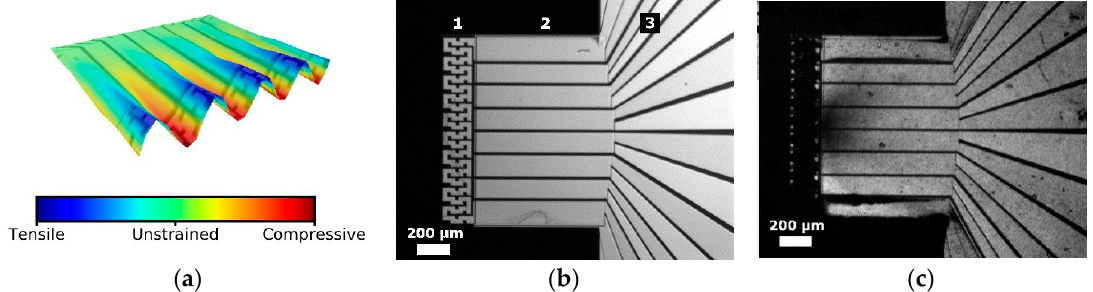
Figure 1. ( a ) Laser Doppler Vibrometer measurement showing the mode shape of the 8th order roof- tile mode. The red and blue colored areas represent the strain distribution (tensile, compressive) on the surface. ( b ) Optical micrograph of the sensor element. The planar coil (1) accumulates the magnetic particles on the cantilever (2) which is fixed to a substrate (3). The patterned electrode design is optimized to excite the 8th order roof tile mode. ( c ) Optical micrograph of the sensor element during the experiment. The accumulation of the 250 nm iron-oxide particles especially at the free end area of the cantilever is clearly